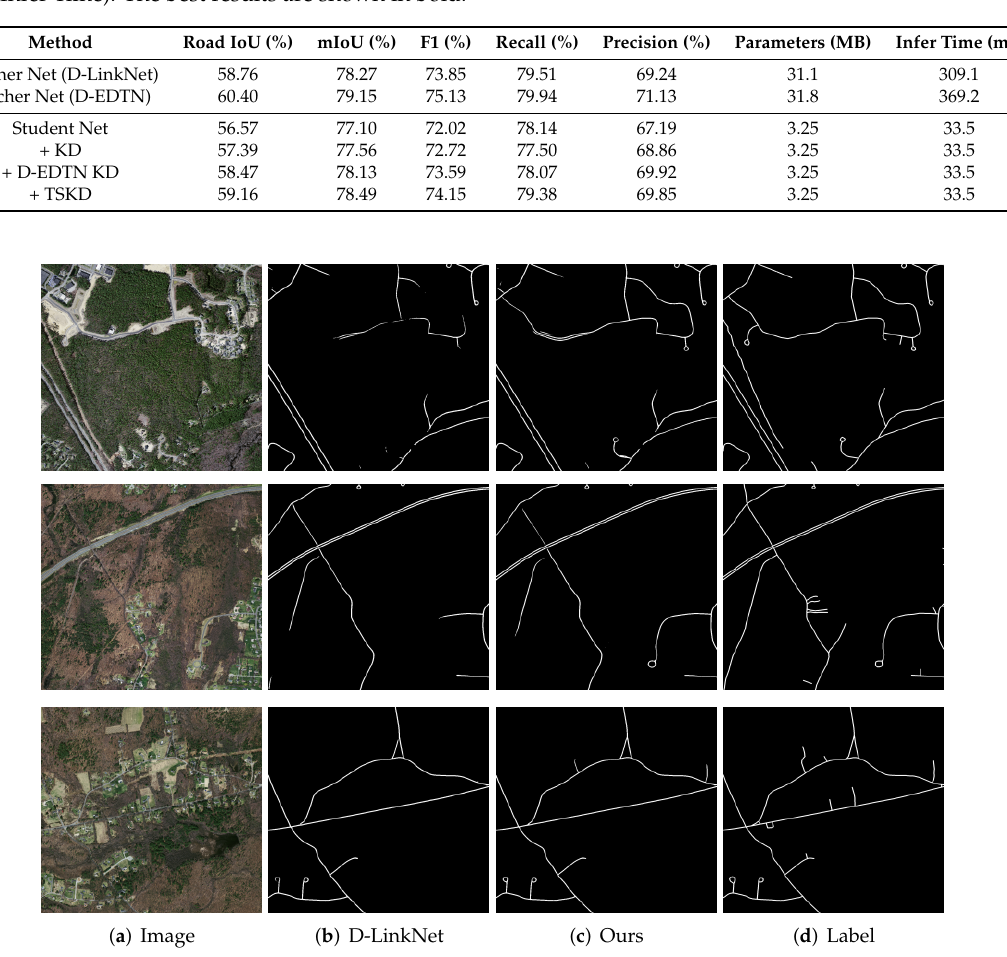
Figure 8. Visual comparisons of the D-EDTN (ours) with the D-LinkNet on the Massachusetts Dataset. The three rows illustrate the results of three images. ( a ) Image; ( b ) results of D-LinkNet [11]; ( c ) our results (D-EDTN); ( d )